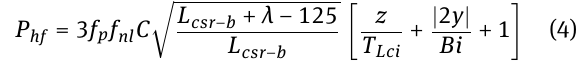
Figure 3: Distribution of hydrostatic pressure at the center of the ship [35].